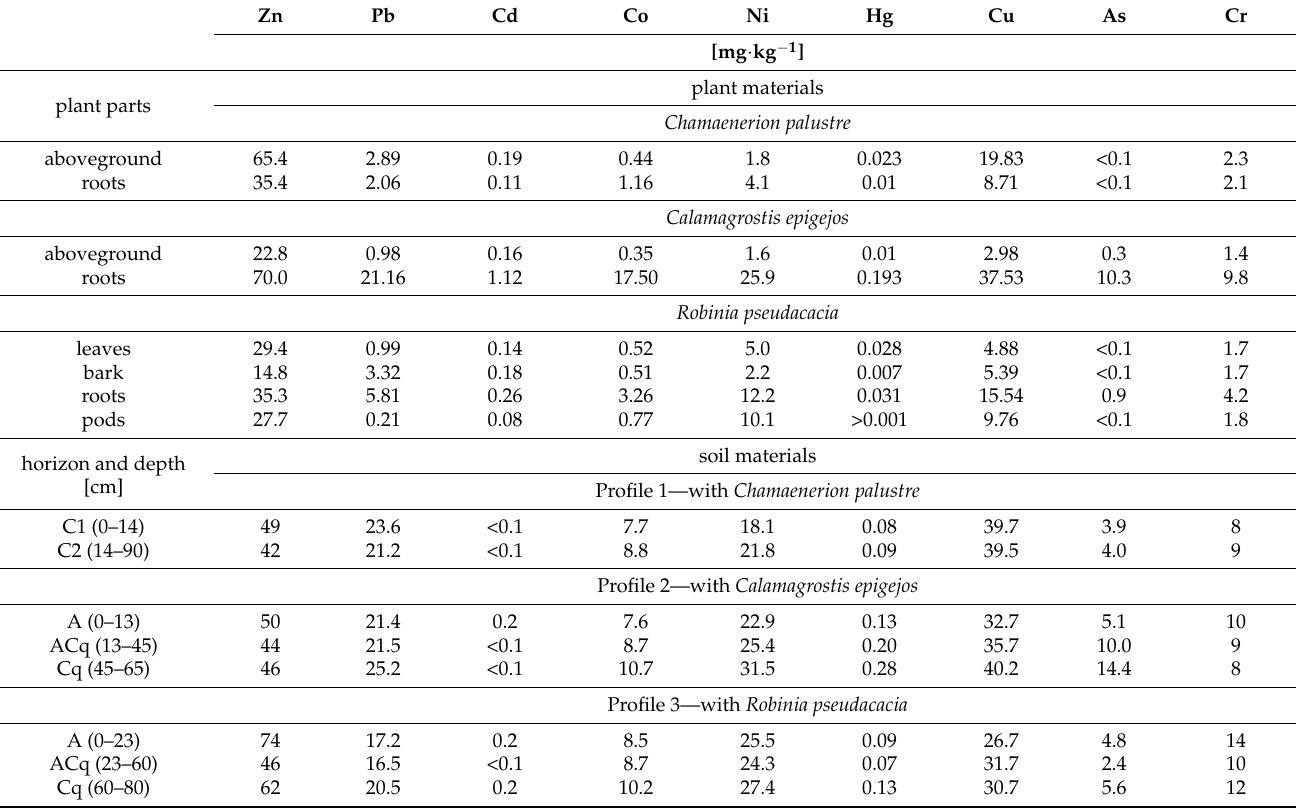
Table 4. Heavy metals content in the plant material and